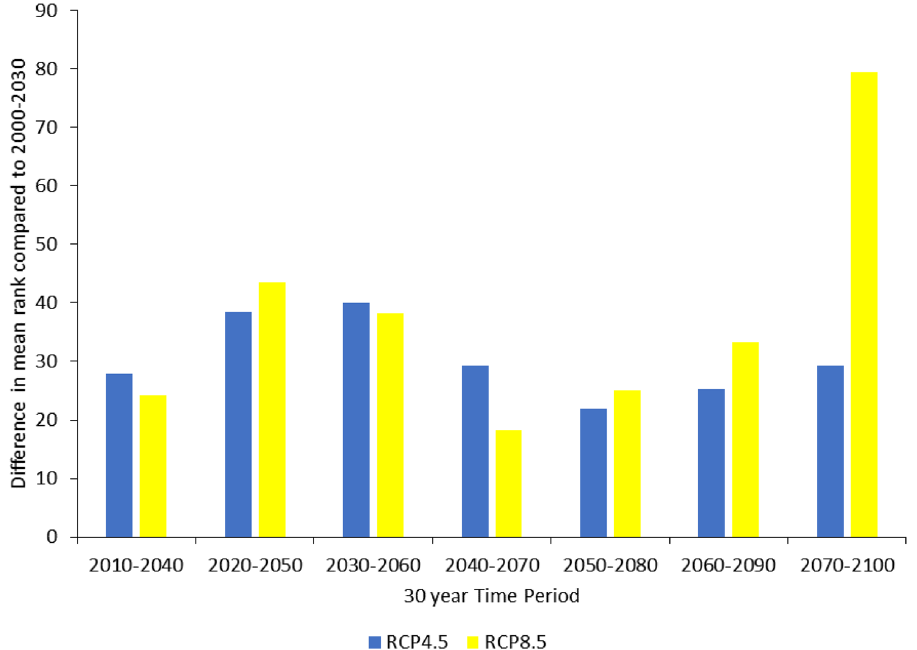
Figure 3. Bar chart showing the difference in mean ranks for Mann Whitney U tests comparing the 2000–2030 and different time periods for RCP4.5 and RCP8.5.